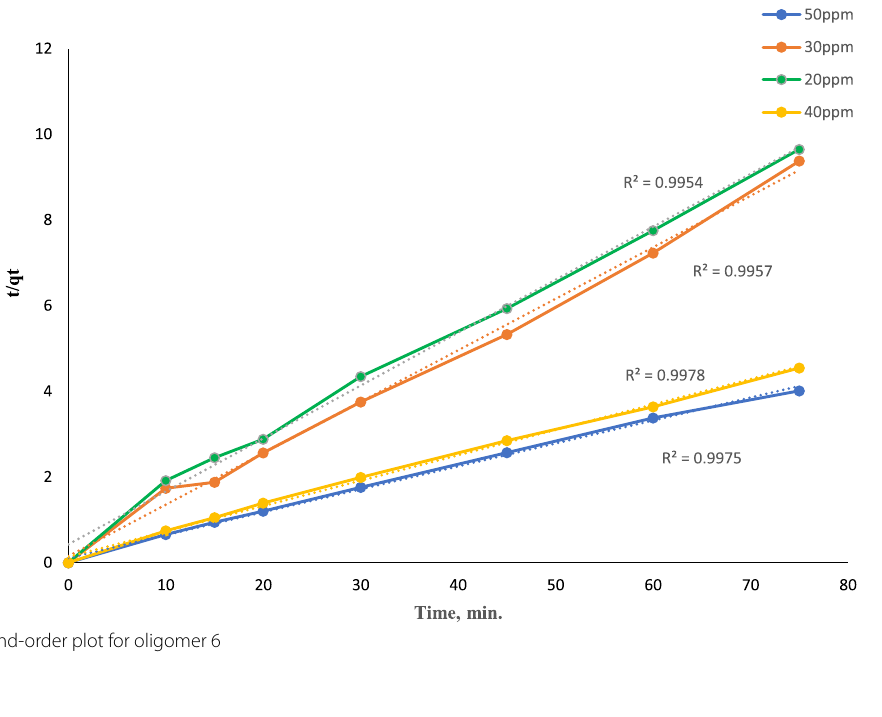
Fig. 9 Pseudosecond-order plot for oligomer 6